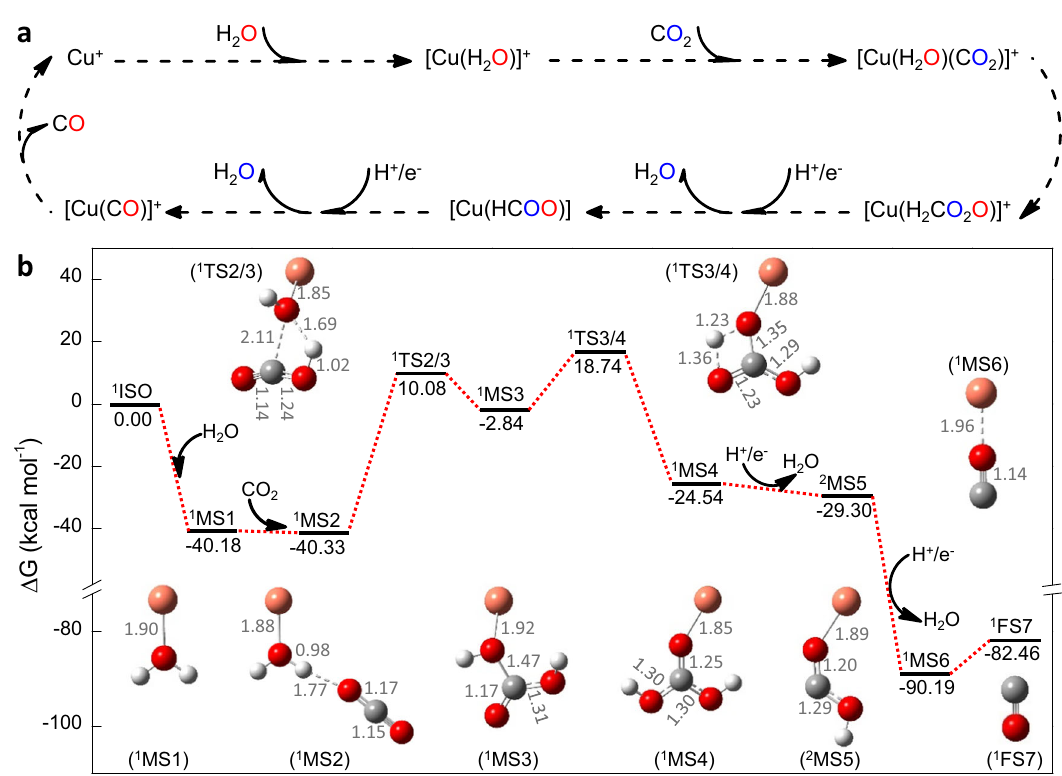
Fig. 6 The mechanism of CO 2 reduction to CO in the presence of Cu(I) catalyst and water. a Schematic representation of the reduction of CO 2 to CO according to experimental observations. b The DFT microscopic reaction pathway [the singlet reactants of 1 Cu + + 1 H 2 O + 1 CO 2 ( 1 IS0, 0.00) was taken to be zero as a reference], demonstrating the thermodynamic and kinetic feasibility of the suggested